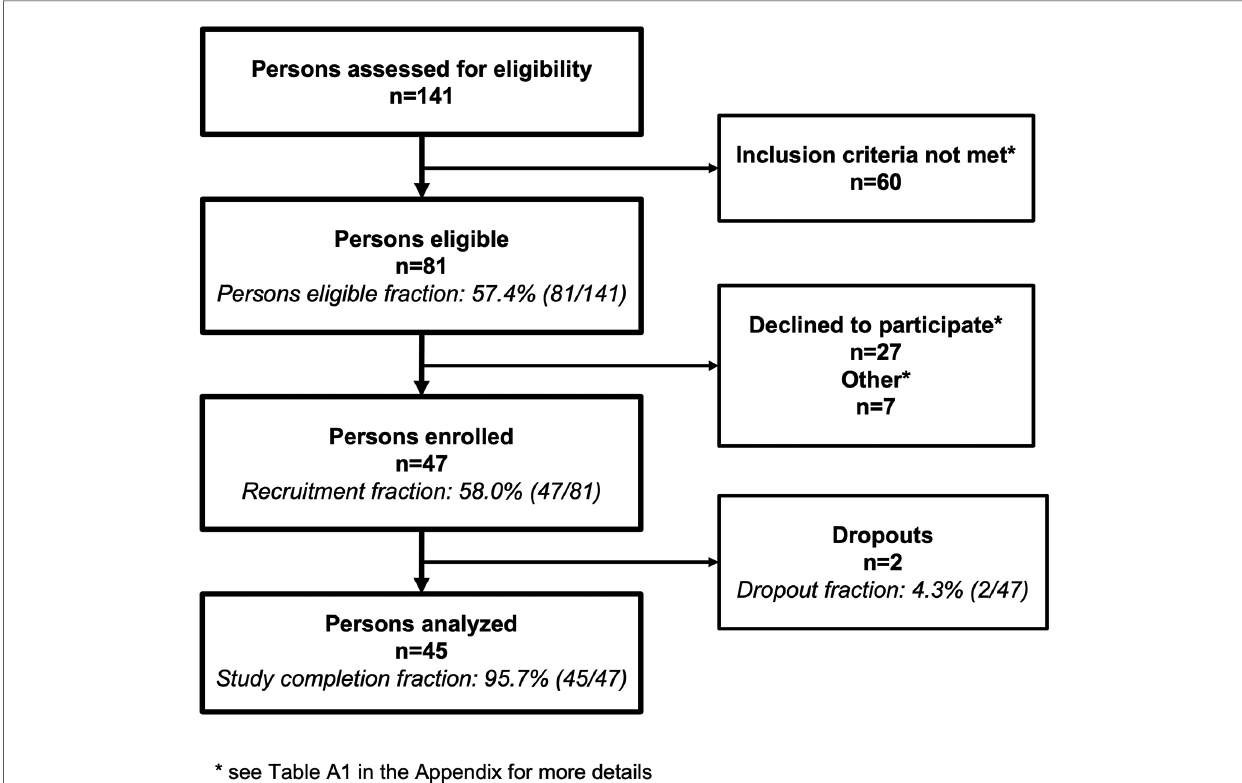
FIGURE 2 Flow chart of the study population. In total, 141 persons were assessed for eligibility, 47 were enrolled, and the data of 45 persons were analyzed. Unmet inclusion criteria and the reasons for declining study participation are presented in Supplementary Table AS3